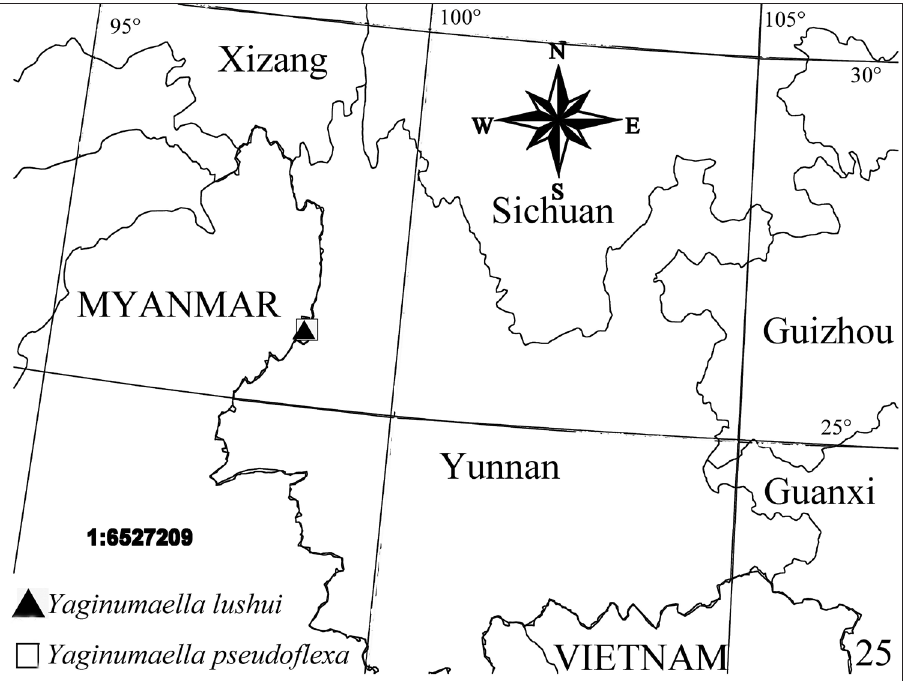
Figures 25. Localities of new Yaginumaella species from China.